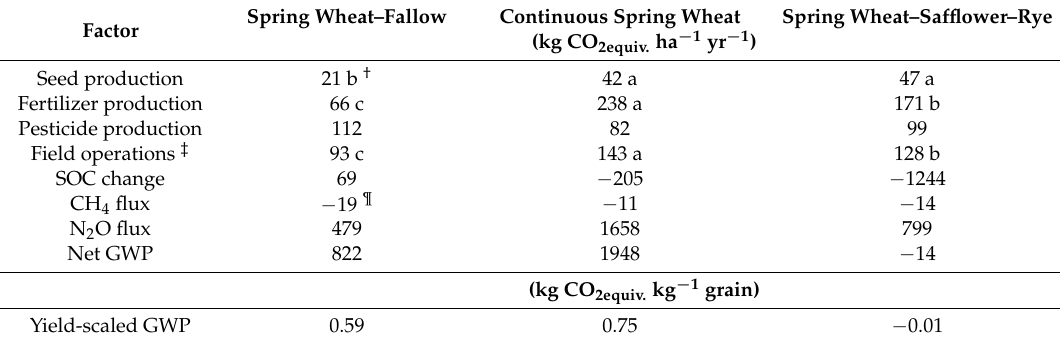
Table 3. Cropping system effects on net global warming potential (GWP), yield-scaled GWP and contributing